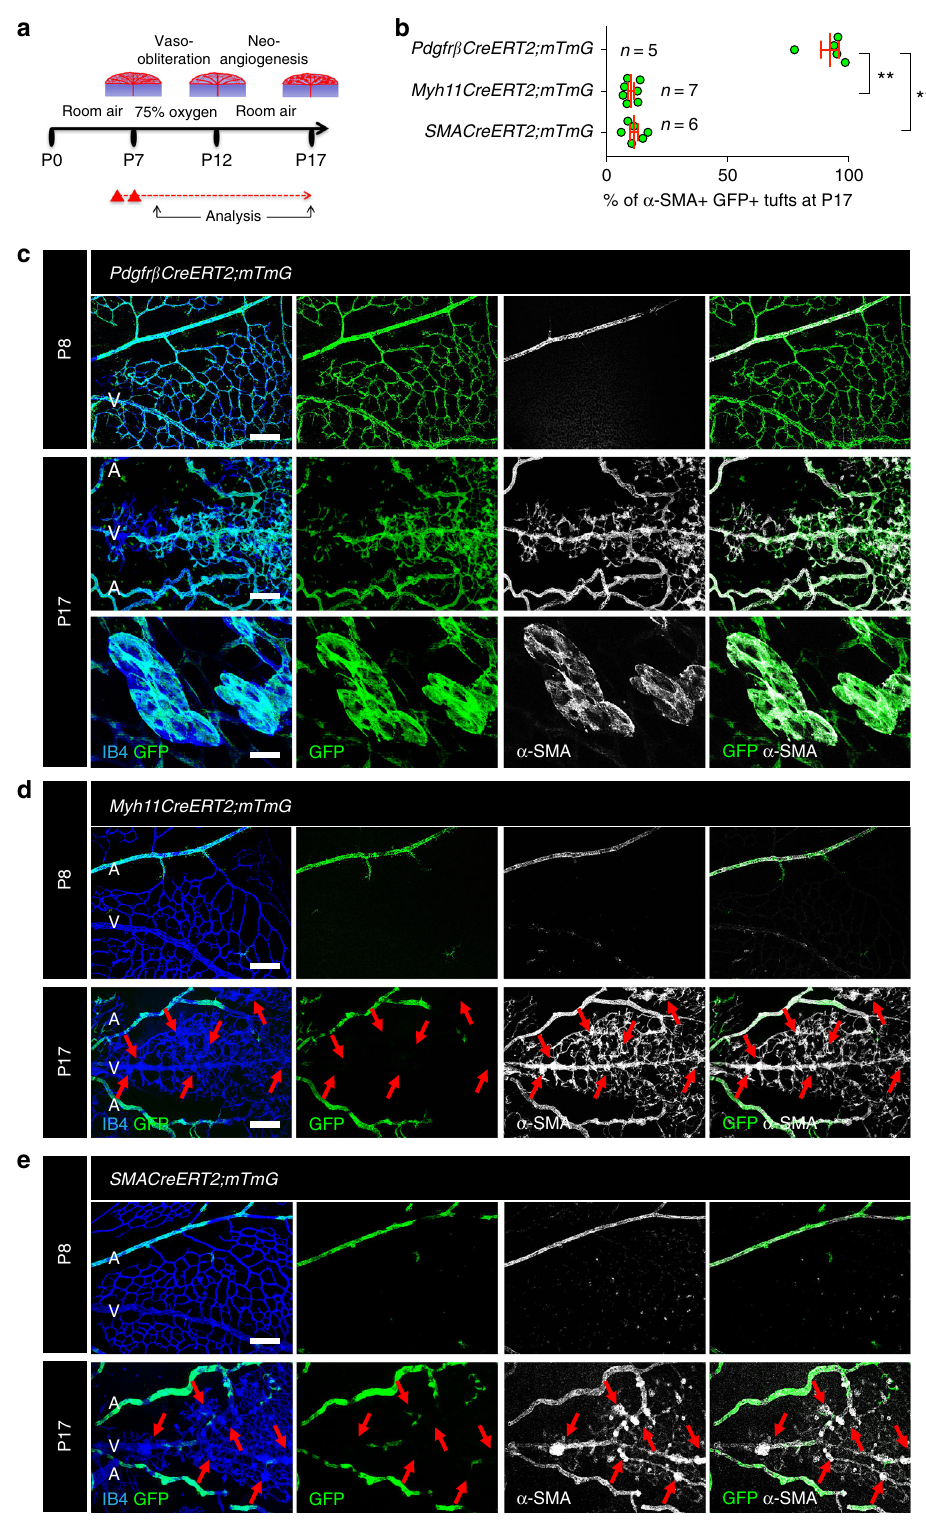
Fig. 3 Mural cells covering tufts are derived from PDGFR β -positive pericytes. a Strategy for genetic labeling of mural cells by tamoxifen treatment (red triangles) in the corresponding CreERT2;mTmG mice. b Quanti fi cation of tufts labeled with α -SMA and GFP in OIR retinas from the indicated P17 mice. The number of retinas used for quanti fi cation is indicated. Error bars: s.e.m. ⋆⋆ P < 0.01, Mann – Whitney U test. c IB4, α -SMA, and GFP triple staining of retinas from P8 and P17 Pdgfr β -CreERT2;mTmG mice. d IB4, α -SMA, and GFP triple staining of retinas from P8 and P17 Myh11CreERT2;mTmG mice. e IB4, α -SMA, and GFP triple staining of retinas from P8 and P17 SMACreERT2;mTmG mice. Red arrows in d and e show α -SMA + GFP − NVTs. Scale bars, 100 μ m ( c top and middle, d , e ) and 60 μ m ( c